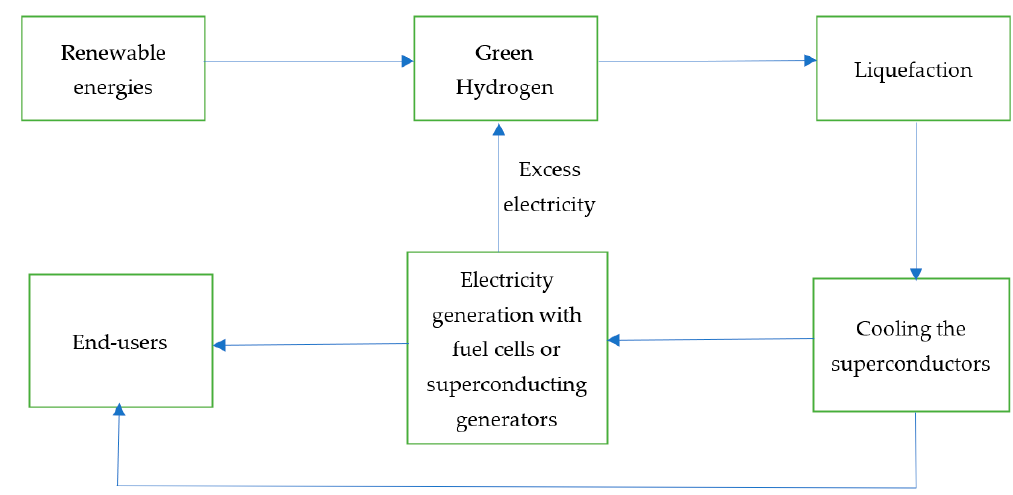
Figure 2. Outlook of the synergy between superconductors and liquid hydrogen.